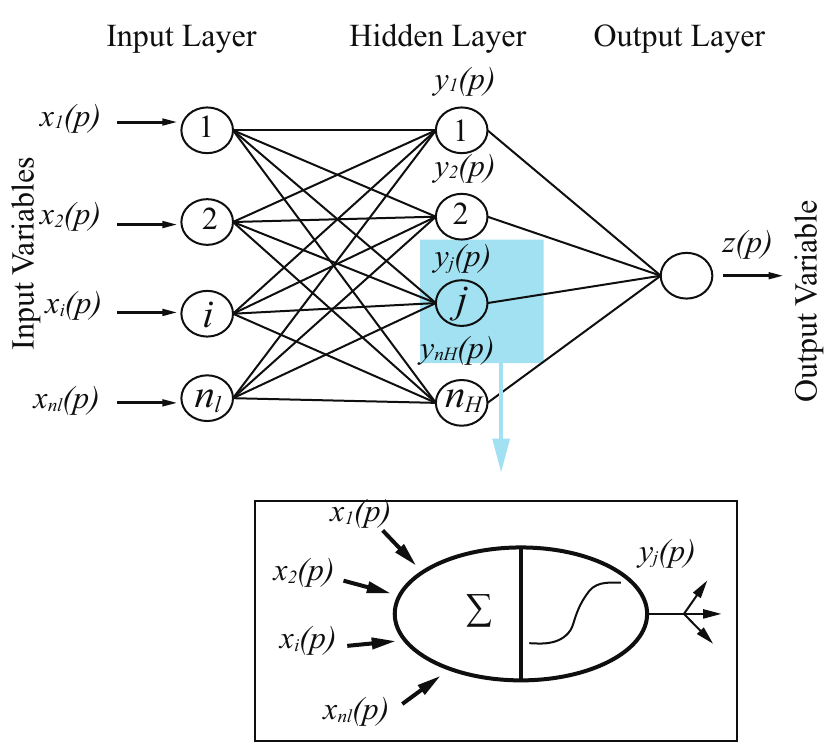
Figure 1. ANN architecture with one hidden layer (typical three-layer feed forward artificial neural networks)